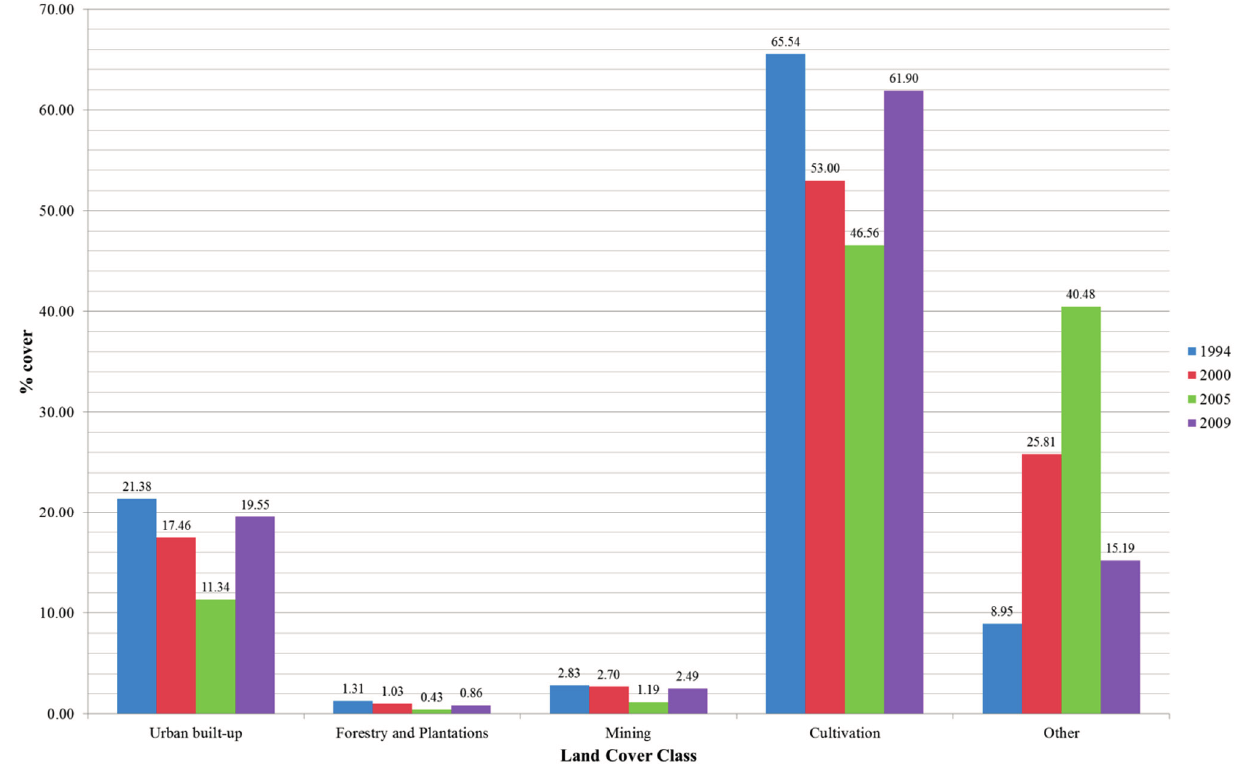
Figure 4. Trends in land cover change within the Blesbok Spruit catchment from 1994 to